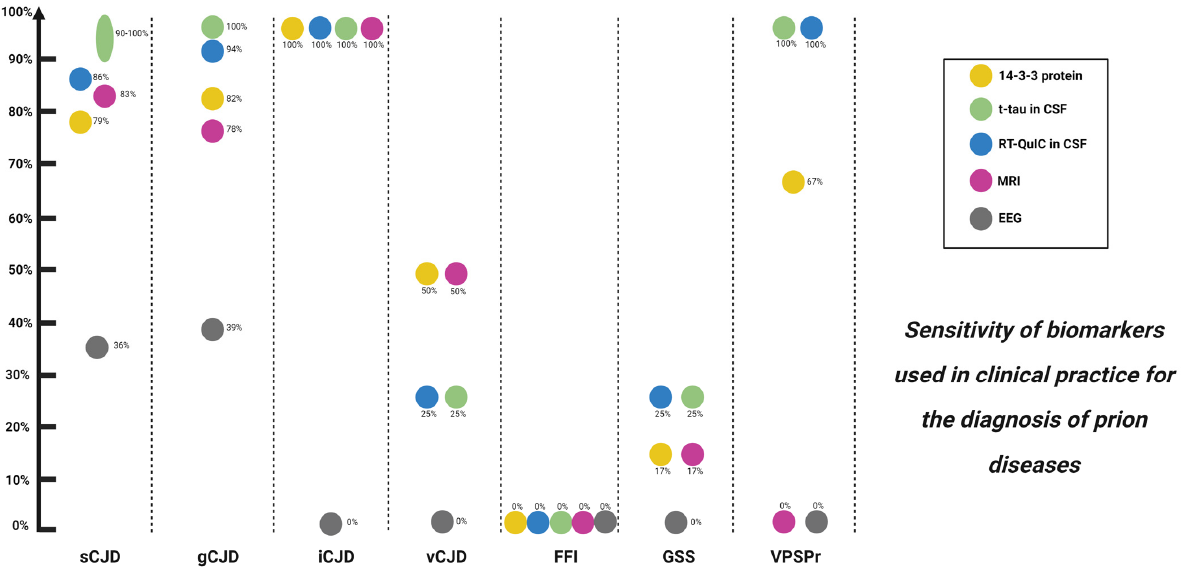
Figure 3. Biomarkers used in clinical practice and their diagnostic sensitivity for prion diseases. sCJD: sporadic Creutzfeldt–Jakob disease; gCJD: genetic Creutzfeldt–Jakob disease; iCJD: iatrogenic Creutzfeldt–Jakob disease; vCJD: variant Creutzfeldt–Jakob disease; FFI: fatal familial